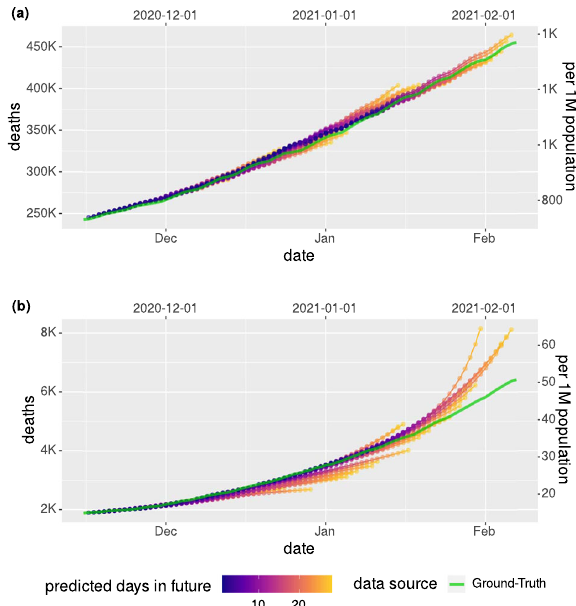
Fig. 2 Prospective forecasts for the US and Japan models. Ground truth cumulative deaths counts (cyan lines) are shown alongside the forecasts for each day. Each daily forecast contains a predicted increase in cases for each day during the prediction window of 4 weeks (shown as colored dots, where shading shifting to yellow indicates days further from the date of prediction in the forecasting horizon, up to 4 weeks). Predictions of deaths are shown for ( a ) the USA, and ( b ) state- and county-level predictions. When evaluating at state level and averaging across all locations, the framework achieves MAPE for cumulative deaths and con fi rmed cases of 5.4% [5.1%, 5.6%]